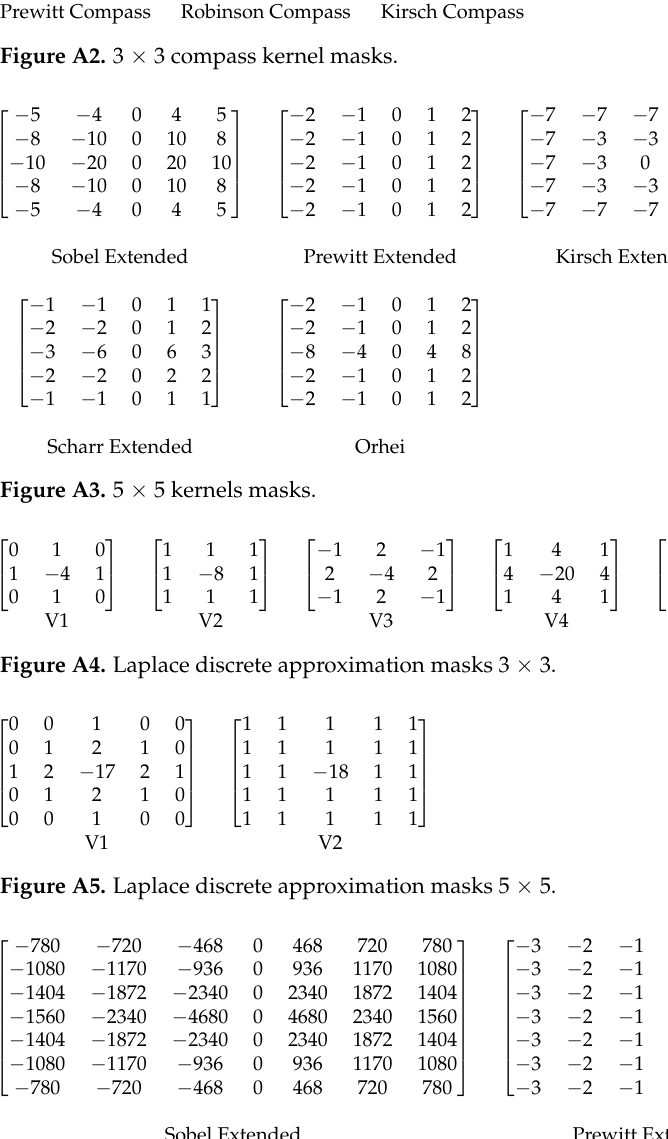
Figure A1. 3 × 3 kernel masks.